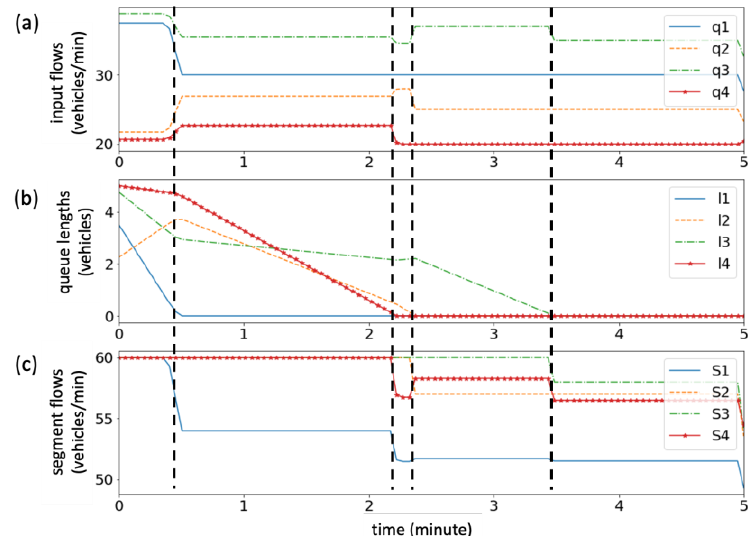
Figure 6. Queue length evolution: ( a ) without queue length upper bound; ( b ) with queue length upper bound.